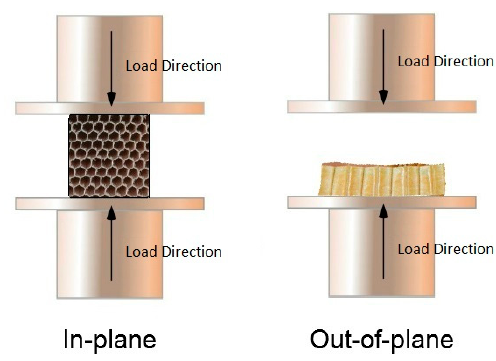
Figure 12. Schematic representation of conducted compression tests.